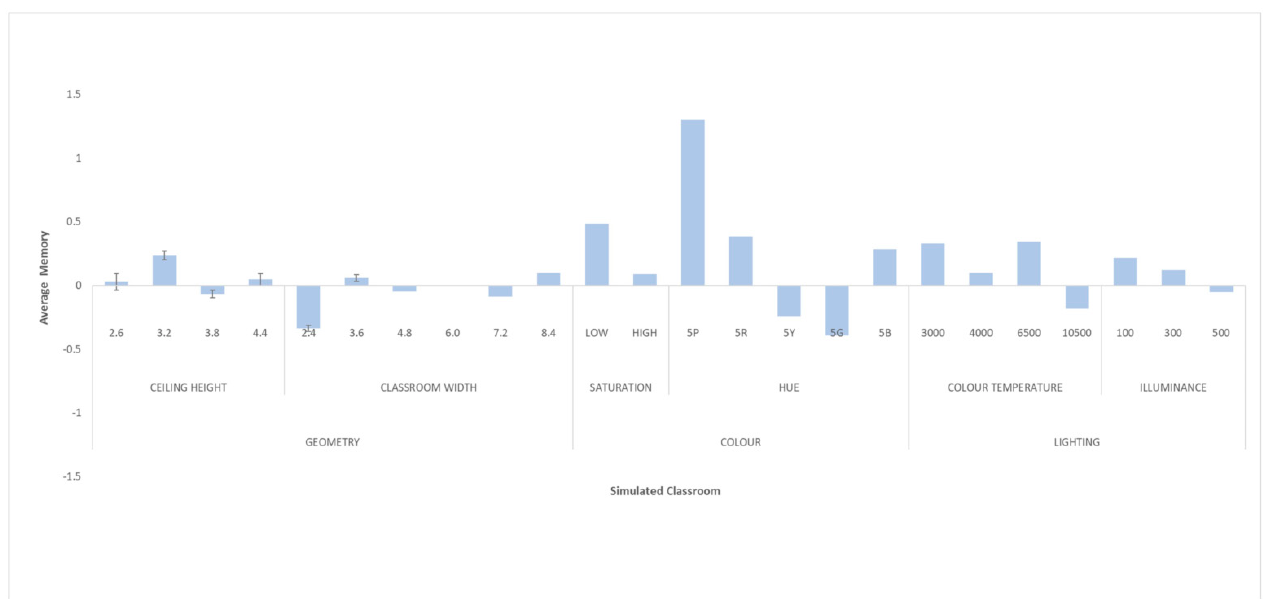
Figure 7. Normalised means of Memory-Correct Answers in men’s sample.